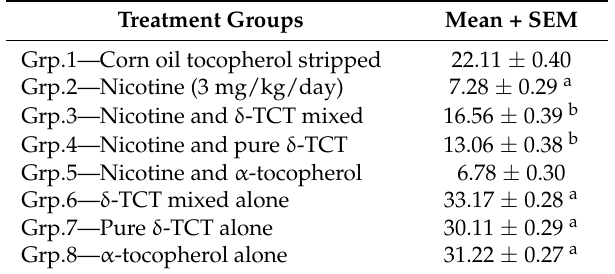
Figure 2. ( a ) Normal 2-cell embryos obtained in Grp.1, Grp.6, Grp.7, and Grp.8. Normal appearances are characterized by the equal blastomere size (double arrows), normal zona pellucida (ZP) lining, and presence of a polar body (thick arrows). Abnormal 2-cell embryos obtained in Grp.2, Grp.3, Grp.4, and Grp.5 is shown in ( b – d ). Abnormal appearances are characterized by ( b ) unequal blastomere size, ( c ) asymmetrical blastomere division, and ( d ) blastomere fragmentations. Table 2. Average number of 2-cell embryos produced per mice per group ( n =